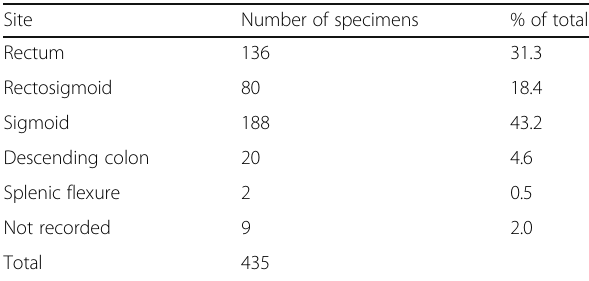
Table 1 Site of pathology